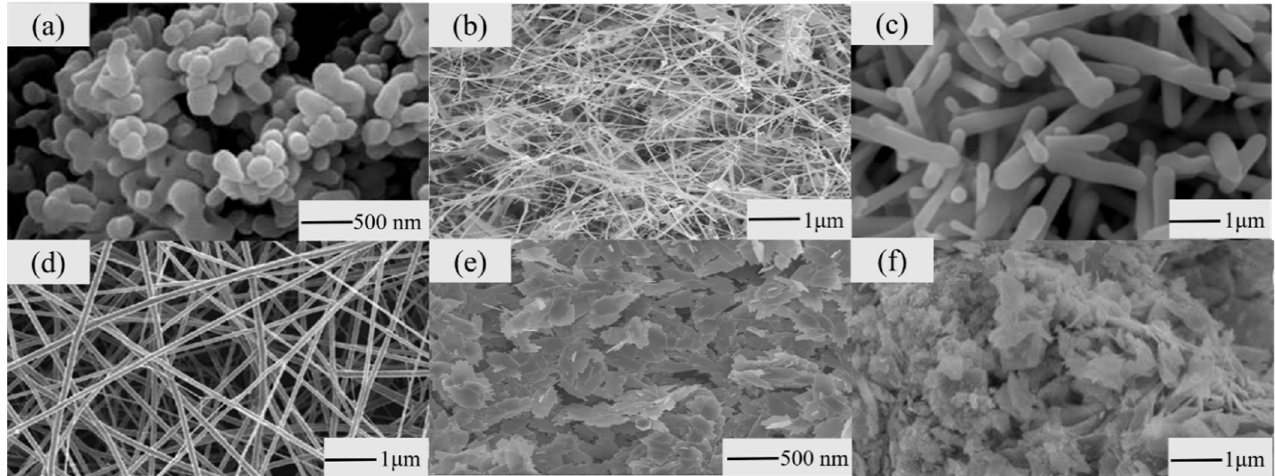
Figure 1. Typical nanostructures. ( a ) Nanoparticles. Adapted from [33] copyright (2015), with permission from Elsevier. ( b ) Nanowires. Adapted from [34] copyright (2008), with permission from Elsevier. ( c ) Nanorods. Adapted from [36] copyright (2014), with permission from Elsevier. ( d ) Nanofibers. Adapted from [37] copyright (2009), with permission from Elsevier. ( e ) Nanosheets. Adapted from [38] copyright (2010), with permission from Taylor & Franics. ( f ) Nanoflowers. Reprinted from [39].